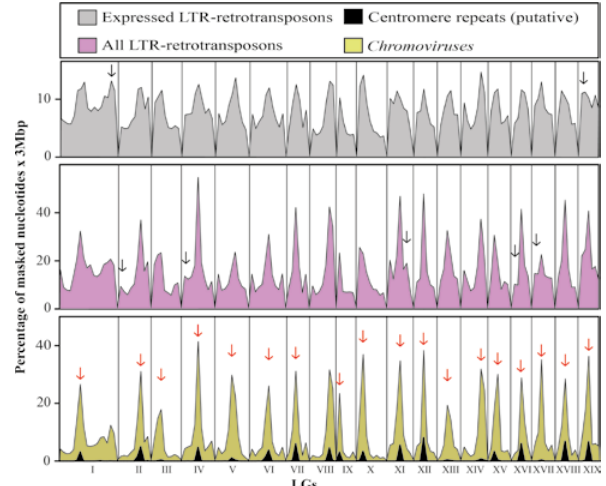
Fig. 4. Percentage of aligned nucleotides along P. trichocarpa LGs using all the full-length LTR-REs expressed in control leaves, all isolated full-length LTR-REs, all isolated Chromovirus REs and a putative centromeric sequence (in black). Red arrows indicate the putative position of the centromeres. Black arrows indicate minor peaks which are especially evident in the expressed LTR-REs pro- files or in the profiles of all LTR-REs.